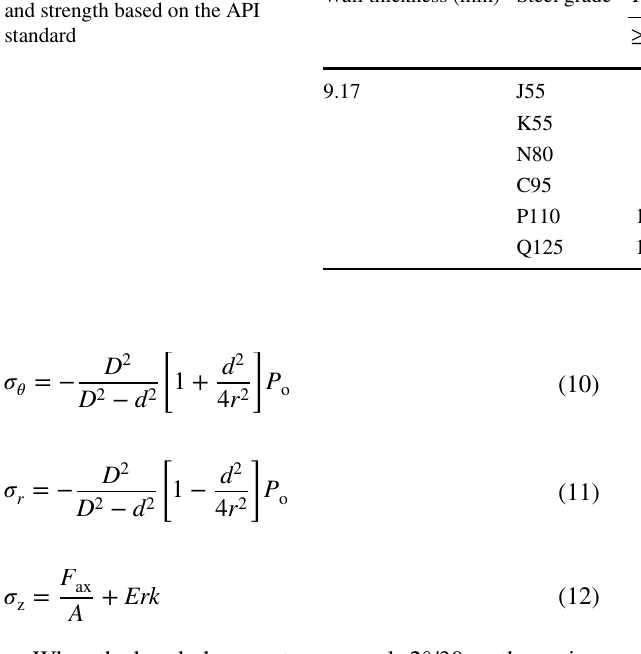
Table 1 Casing size, grade and strength based on the API standard